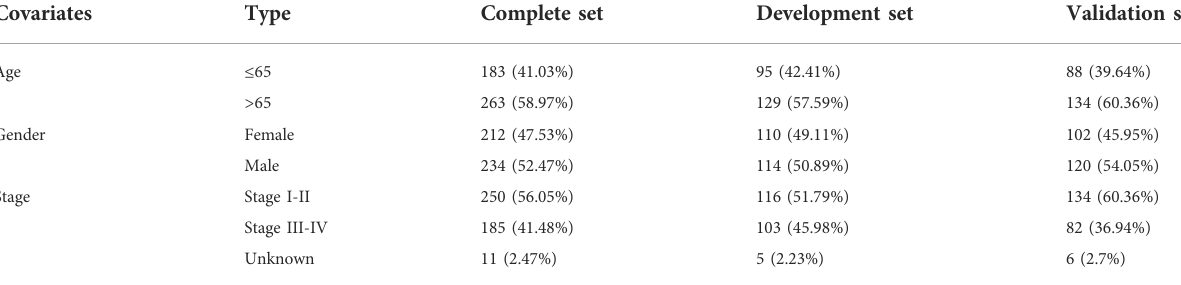
TABLE 1 Clinical baseline features of samples in training and validation